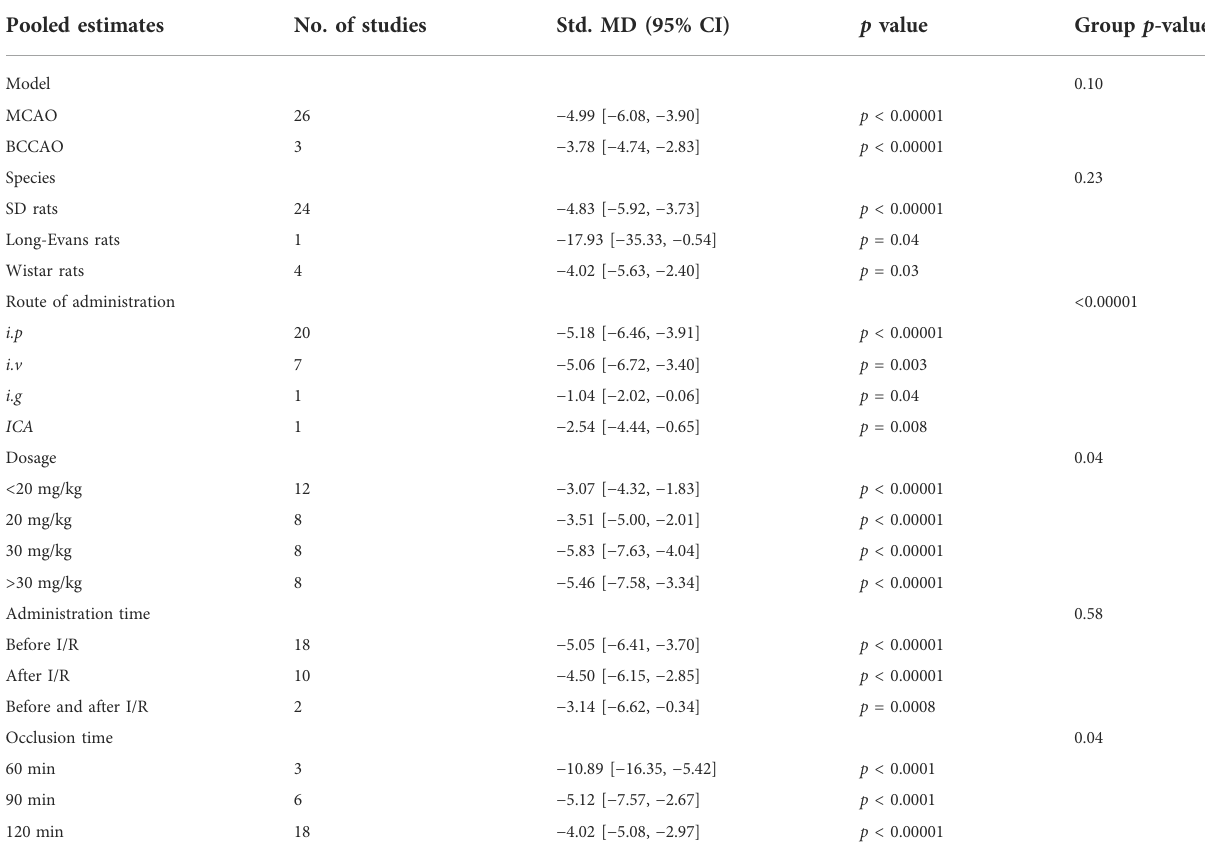
TABLE 3 Summary of subgroup analysis on cerebral infarct volume. Pooled